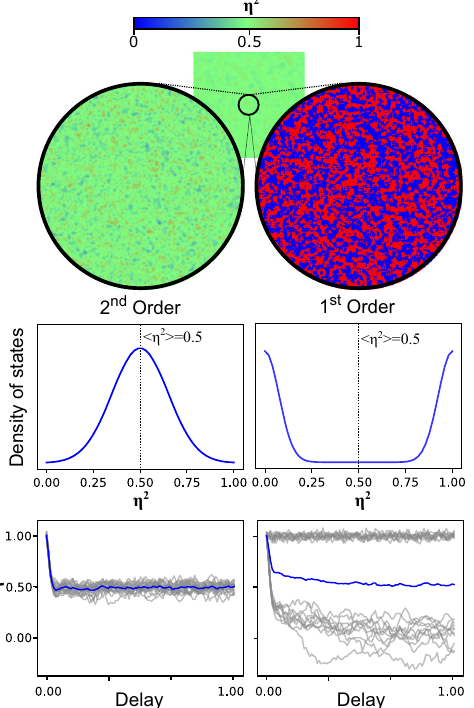
Fig. 1 Beyond Ginzburg-Landau for atomic-scale dynamics. A schematic of a spatially resolved order parameter measured on the mesoscale after photoexcitation during an ultrafast disordering transition for a second-order transition (left) and fi rst order (right). An average value of η 2 = 0.5 is measured for the order parameter in both cases. For second-order transitions, the order parameter can take a continuum of values, and transitioning from the mesoscale to the atomic scale preserves the order parameter. The system is uniformly partially melted with a local order parameter distribution peaked at 0.5. The local dynamics are similar to the average, despite the disorder. However, for fi rst-order transitions, the order parameter can take one of two values (0, 1). In this case, the atomic-scale view shows a bi-modal distribution peaked at either zero or 1, and no part of the system is at the averaged value, nor are the dynamics of the average order parameter re fl ected in the averaged response. Such distributions require physics beyond the mean- fi eld to